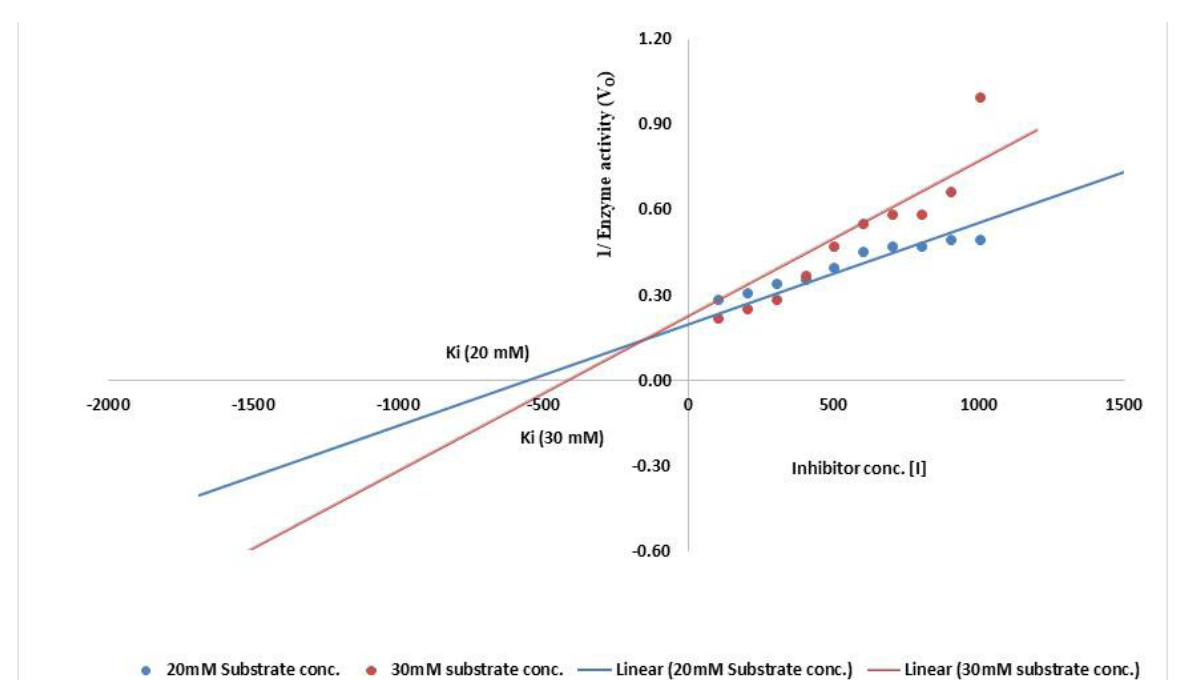
FIGURE 4 - Mixed type of invertase inhibition (Dixon plot) by diferuloyl glycerate related phenolic